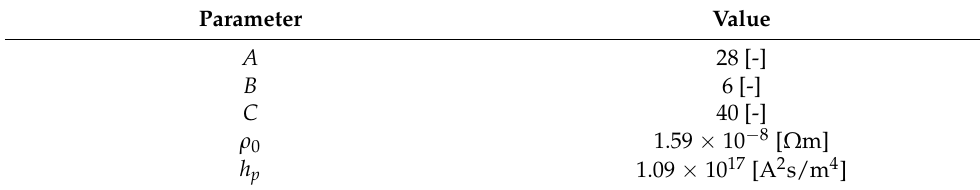
Figure 11. Characteristics of the relative increase in fusible material resistivity as a function of the Joule integral related to the square of the fusible elements effective cross-section area with the variability range marked; in red—results of experimental research, in black—model approximation. Table 4. Fusible elements disintegration model